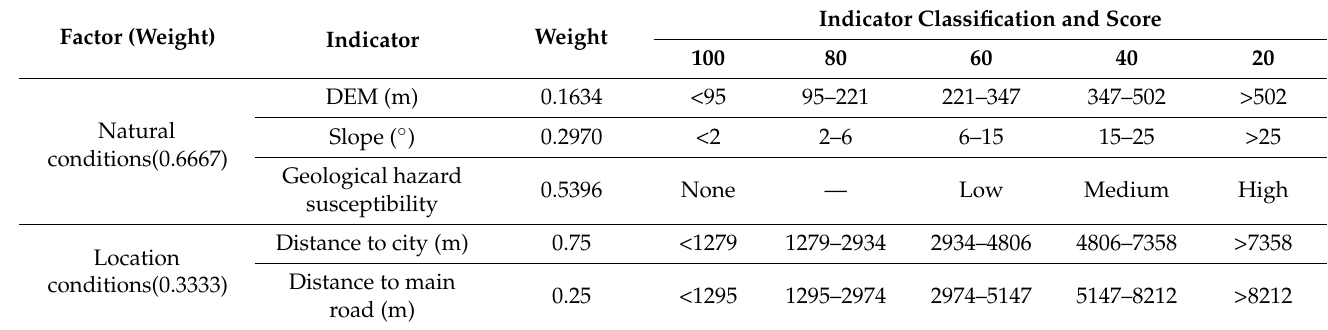
Table 1. Evaluation index system for construction land suitability.